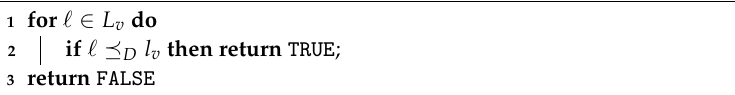
Algorithm 3: BLACK _ BOX _ DOM ( L v , (cid:96) v ) for MD algorithm, d ≥